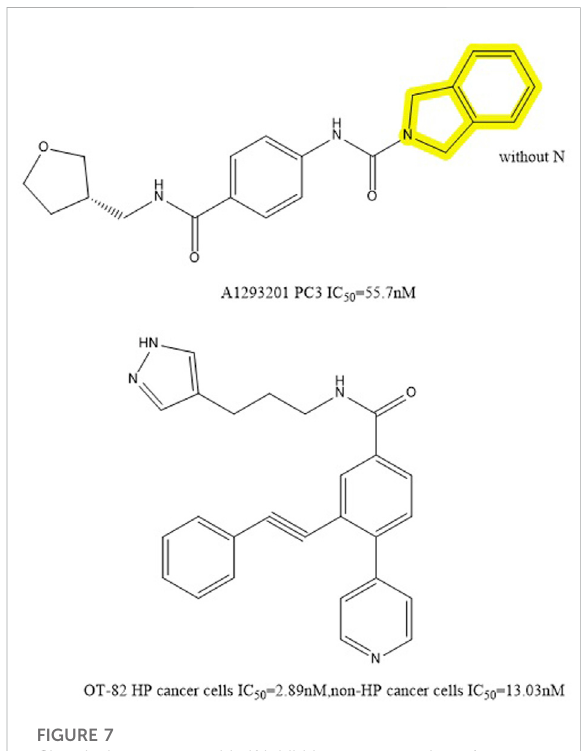
FIGURE 7 Chemical structure and half inhibition concentration of A1293201 and